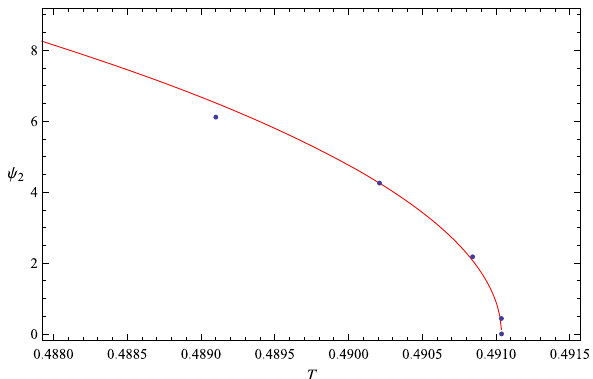
Fig. 4 We plot the hairy black hole phases by solid blue points. The solid red line corresponds to the function of ψ 2 = 148 ( T − T c ) 1 / 2 with T c = 0 . 4910